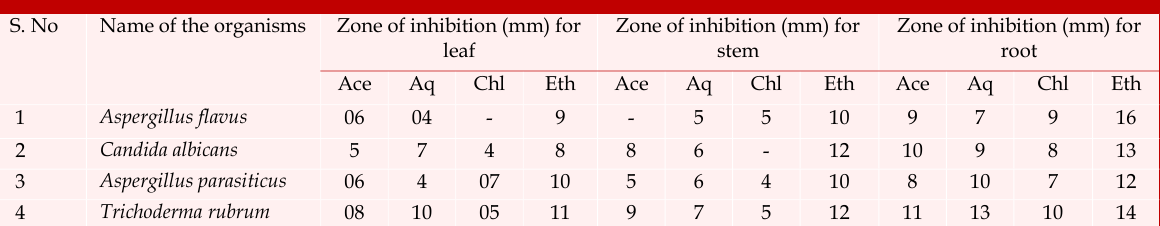
Antifungal activity of coleus forskohlii with different